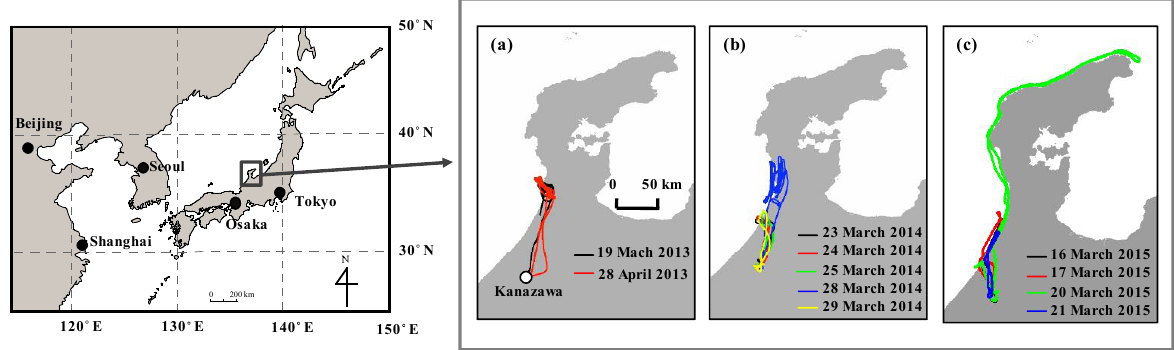
Figure 1. Sampling location and helicopter flight routes during the sampling periods on (a) 19 March and 28 April 2013; (b) 23, 24, 25, and 29 March 2014; and (c) 16, 17, 20, and 21 March